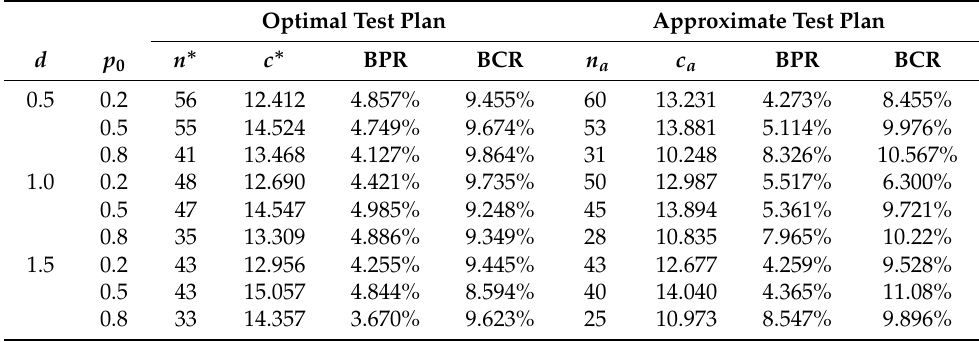
Table 3. Optimal and approximate plans, ( n ∗ , c ∗ ) and ( n a , c a ) , and the corresponding Bayesian risks, BPR and BCR, when µ 0 = 0.35, µ 1 = 0.65, α = 0.05, β = 0.10 and d 0 = d 1 = d .